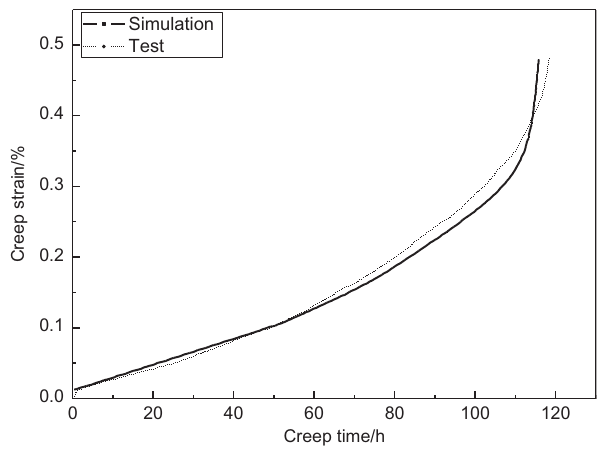
Figure 5: The simulation and test creep curves for specimen without multi-inclined holes under 90MPa at 850 ℃ .